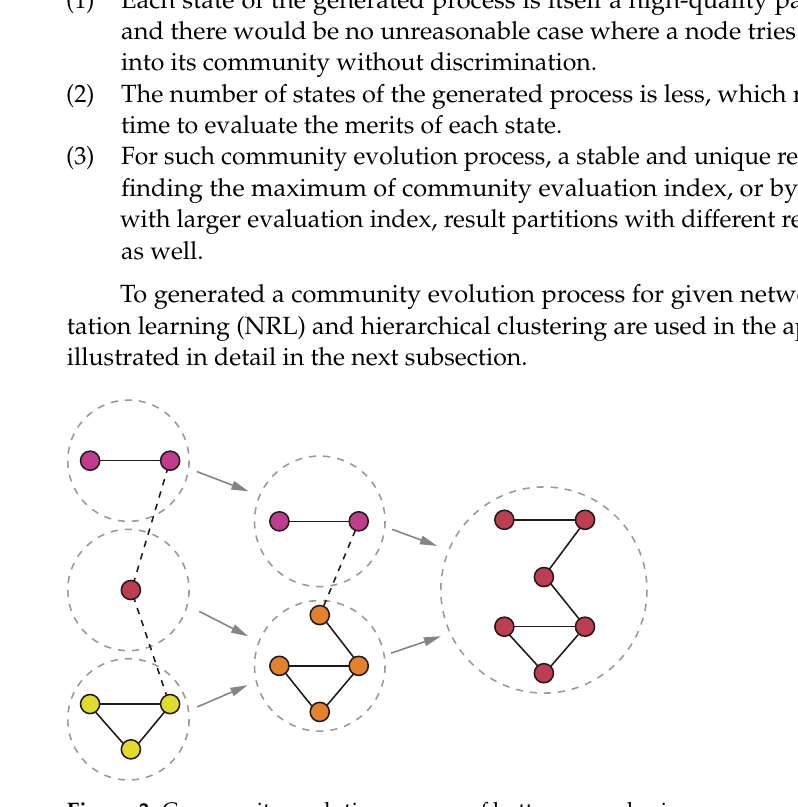
Figure 3. Community evolution process of bottom-up